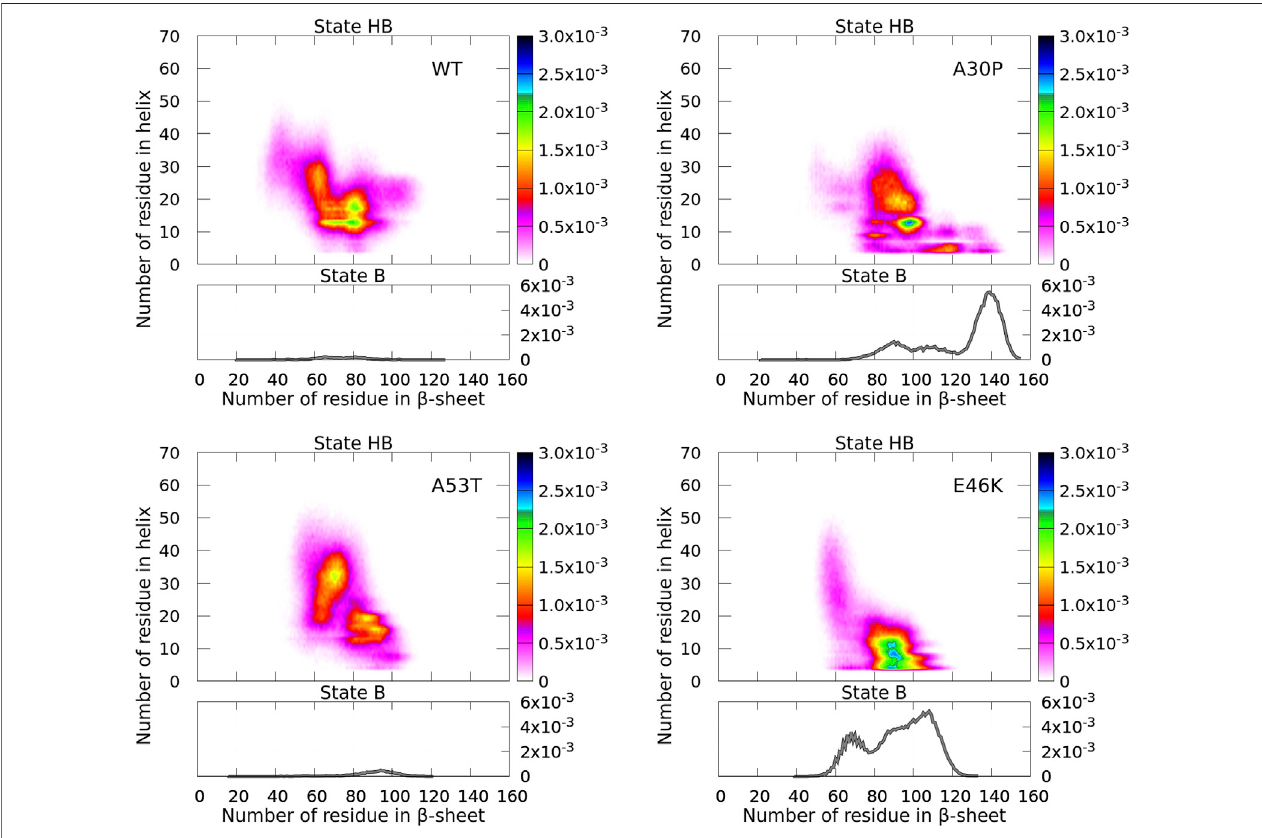
FIGURE 4 | Probability density of the number of residues in α -helices and β -sheets for the WT and mutants of α -syn. The probability density of state B (no helix) is represented by a function (gray) (right vertical axis), and the probability density of state HB is represented by a two-dimensional map (right color bar).